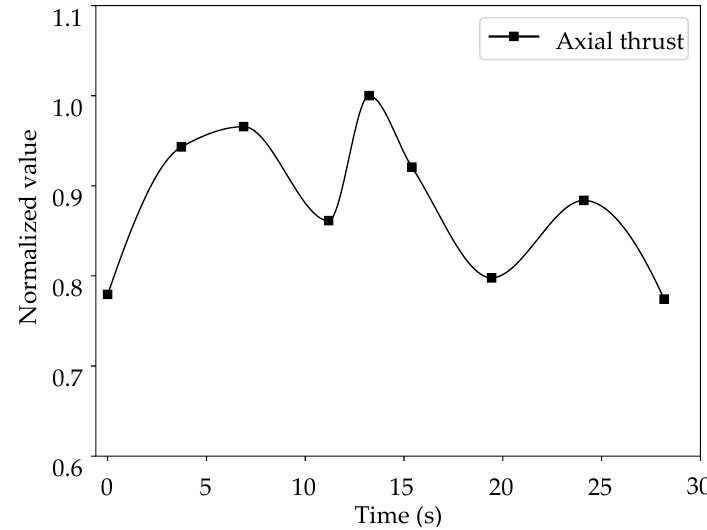
Figure 13. Axial thrust of the head-cover during load rejection. The maximum deformation of the structures induced by unsteady flow during load rejection is also changing with time, but the deformation distribution at the different moments keeps the same pattern, as shown in Figure 14. Flange beams and bolt flanges are used to strengthen the connections between the stay ring and the head-cover and the bottom ring. The adjacent head-cover bolts (bolt couple) between the flange beams are deformed close to each other, resulting from the hydraulic forces induced by the unsteady flow. The same deformation characteristics are also present on the bottom ring bolts.